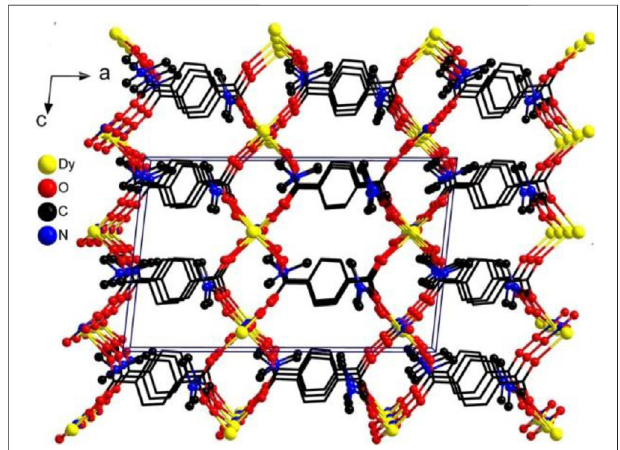
FIGURE 2 | The framework of complex